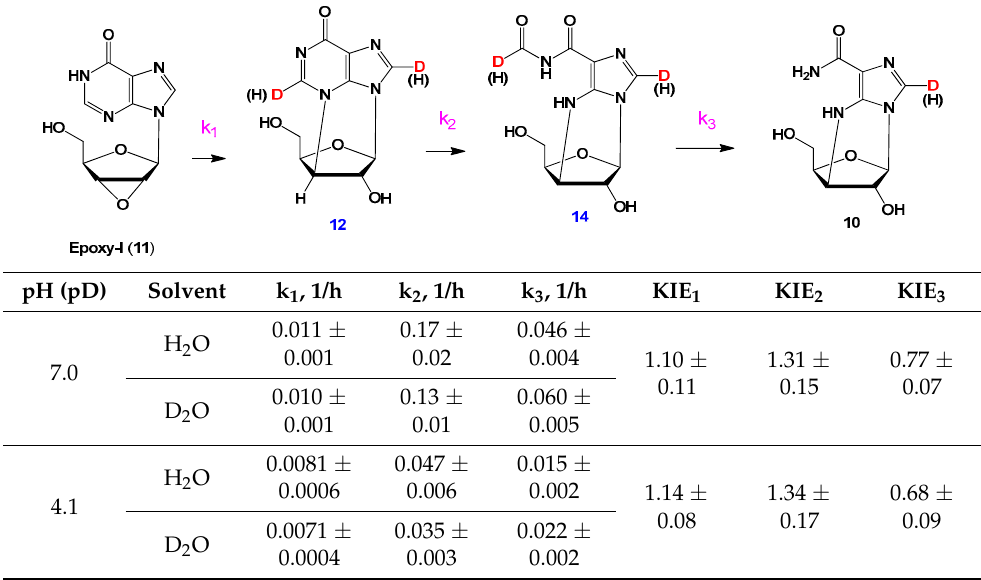
14 Figure 12. PNP activity for inosine (green), 3 ′ -deoxyinosine (orange), and 2-fluoroadenosine (yellow) phosphorolysis in the presence of compounds 10 , 11 , 12 , and 14 . It can be seen that neither compound 11 nor compounds formed from 11 affect E. coli